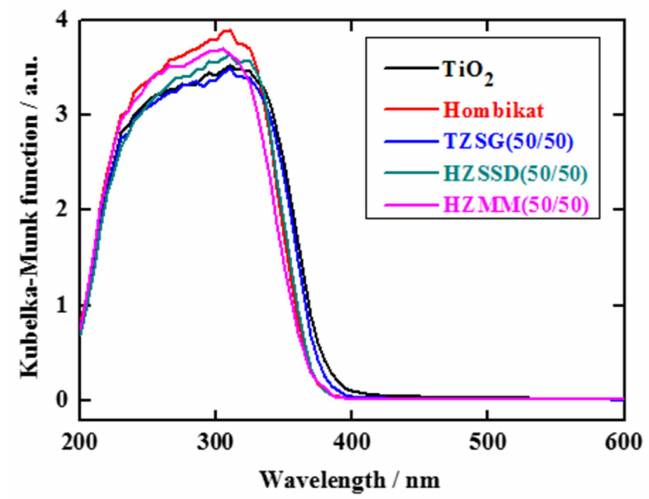
Figure 4. Diffuse reflectance UV-Vis absorption spectra of TiO 2 from sol-gel synthesis, Hombikat, and the composites TZSG (50/50), HZSSD (50/50) and HZMM